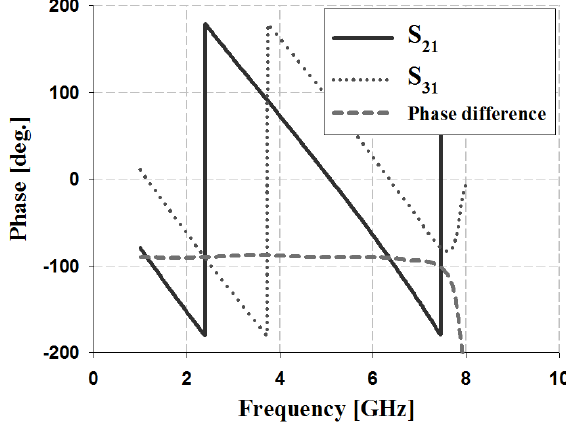
Figure 7. Phase and phase difference simulation analysis of the proposed coupler.